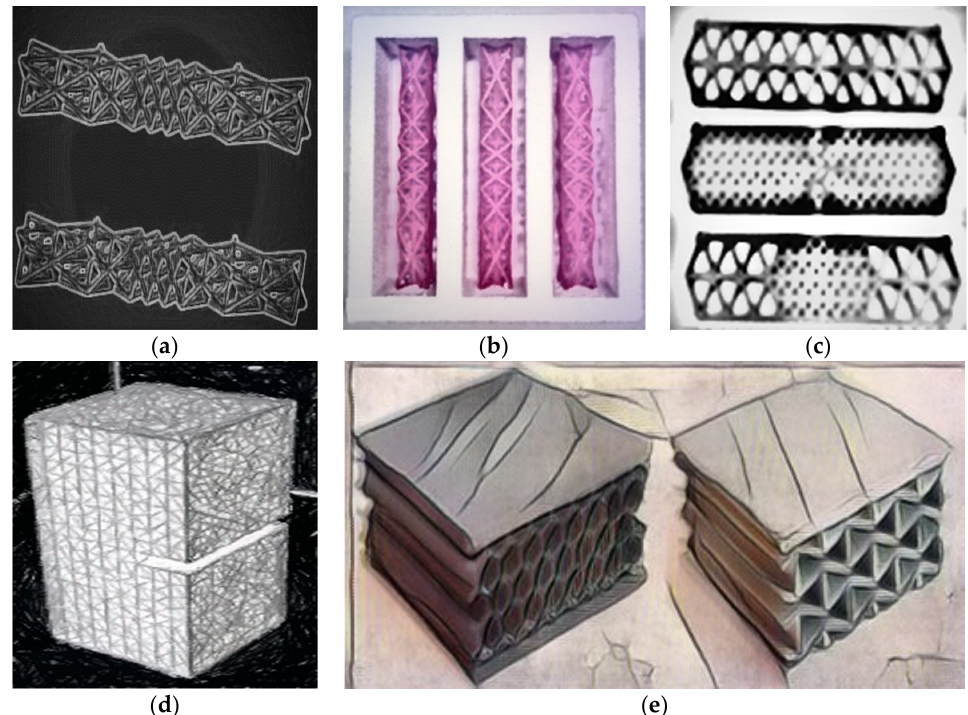
Figure 8. ( a ) functionally graded octet lattice structures; ( b ) printed specimens in polystyrene molds; ( c ) printed reinforcement with different triangle patterns; ( d )printed specimens with a notch for tensile testing; ( e ) examples of 3D printed PLA sandwich panels . Images created by A. Skoratko (inspired by [57–60]).